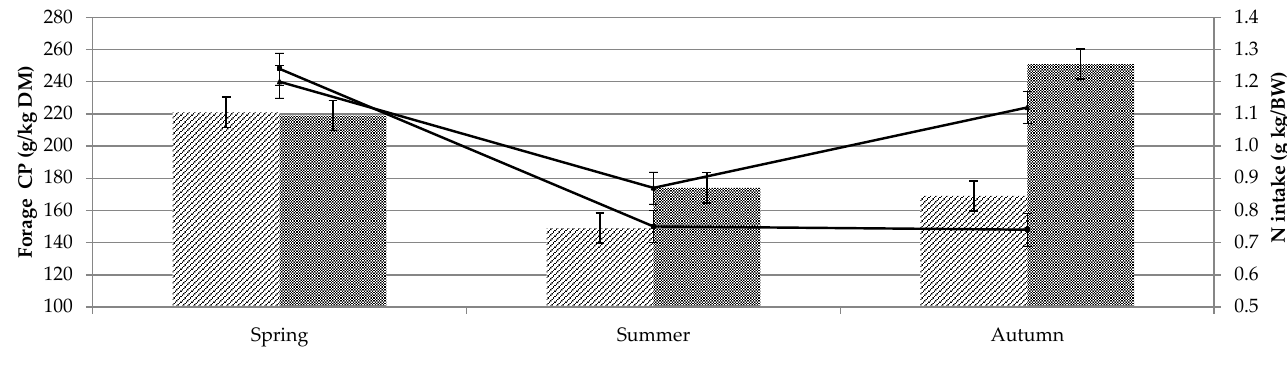
Table 3. Effect of forage type (grass-only and grass-clover) offered to individually housed sheep in spring (27 March – 29 April), summer (19 June – 22 July) and autumn (4 – 29 September) on voluntary dry matter intake (DMI) per body weight (BW), digestible organic matter intake (DOMI) and intake of chemical components. LSMeans for the interaction are presented.